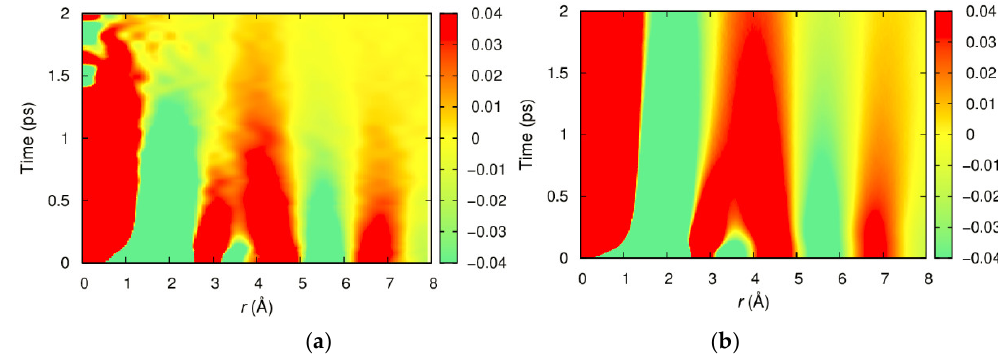
Figure 7. The Van Hove function, G ( r , t ) − 1, for water at room temperature ( a ) determined by inelastic X-ray scattering, ( b ) by molecular dynamics simulation [32].